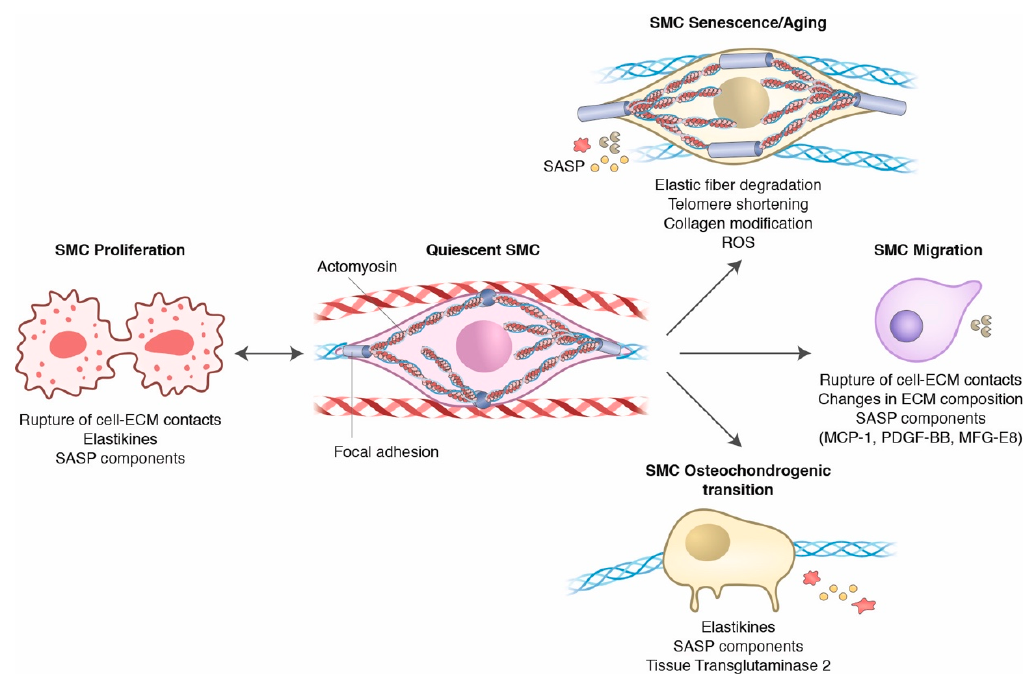
Figure 2. SMC phenotypical changes with aging. Quiescent SMCs are connected to elastic fibers through focal adhesions, modulating actomyosin tension and promoting an ideal mechanical phenotype. Age-induced elastic fiber fragmentation disrupts a signaling pathway that prevents SMC proliferation, providing bioactive peptides (elastikines) that induce SMC proliferation. As elastic fibers protect SMCs from hemodynamic stress, after elastic fiber fragmentation, SMCs stiffen, increasing actin polymerization, focal adhesion size and collagen secretion as a means of dampening the excessive mechanical stress. Collagens surrounding SMCs become progressively glycated, which further reinforces SMC stiffening. Reactive oxygen species (ROS) generated as a response to stress and telomere shortening promote SMC senescence, which is accompanied by the senescence-associated secretory phenotype (SASP), characterized by secretion of cytokines (such as MCP-1), growth factors (PDGFs) and ECM Proteases (MMPs). These factors, together with changes in the microenvironment, favor SMC migration. Changes in ECM and SMC senescence may also favor the osteochondrogenic phenotype, involved in calcification and vascular stiffening.